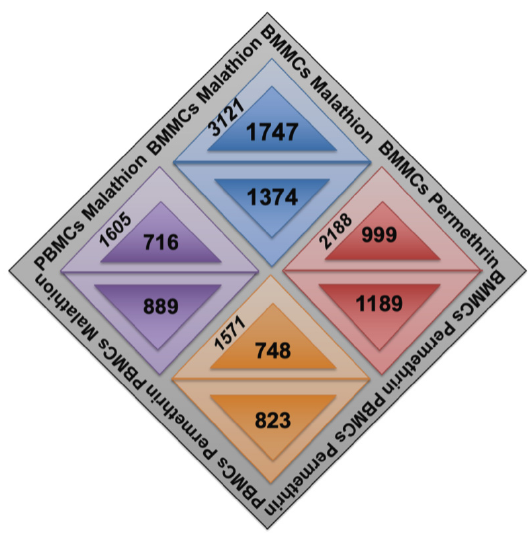
Figure 1. Distribution of genes with low expression (upside down triangles) and with overexpression (triangles looking up) on each microarray. Gene expression was analyzed in PBMCs and BMMCs exposed in vitro to permethrin or malathion. Each colored rhombus belongs to a specific treatment condition.